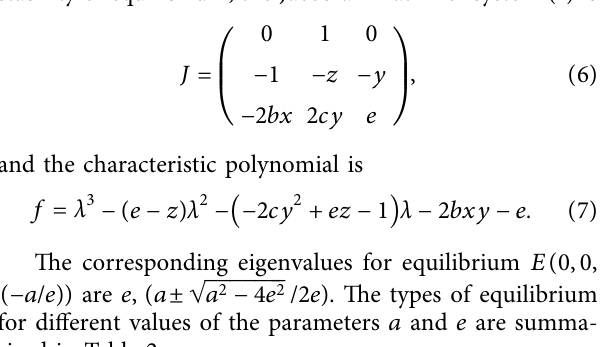
Figure 4: Coexisting attractors of system (1) in c � 1and e � 0 at various values of a : (a) chaotic attractor coexists with a torus in system (1) with a � − 1 and b � 0; (b) chaotic attractor coexists with limit cycle in system (1) with a � − 6.17 and b �− 1; (c) two limit cycles coexist in system (1) with a �− 4.5 and b �− 1; (d) three limit cycles coexist in system (1) with a � − 0.8 and b � − 1. Table 2: Types of equilibrium for different values of parameters a and e